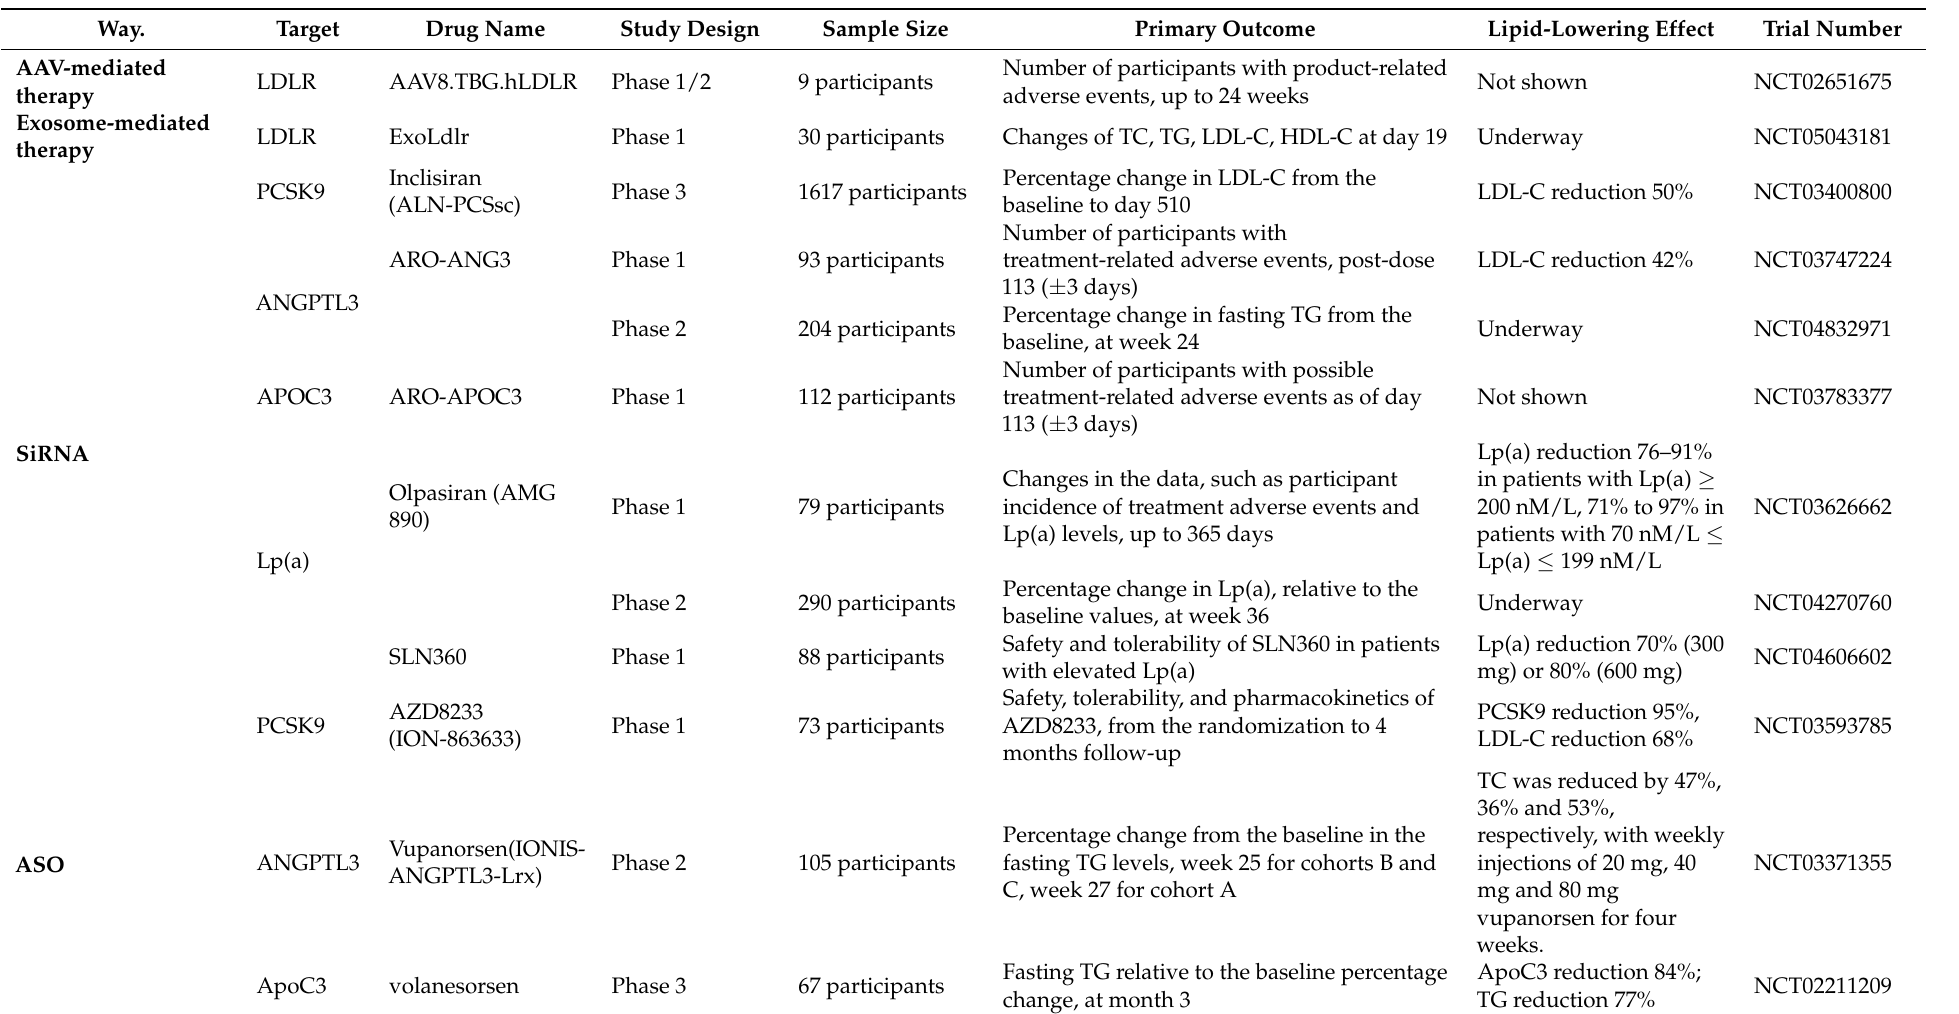
Table 1. Clinical trials for gene